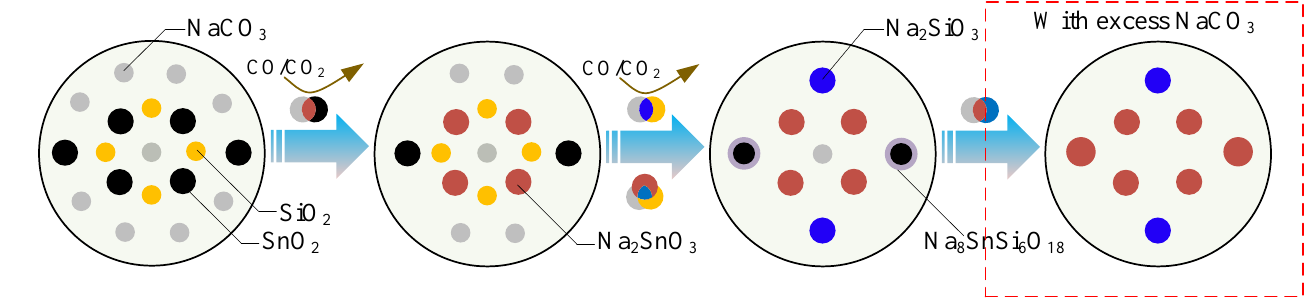
Figure 12. Phase evolution in the SnO 2 – SiO 2 – Na 2 CO 3 system during soda roasting process. First, SnO 2 reacted with Na 2 CO 3 to form Na 2 SnO 3 as shown in Equation (2). Mean- while, part of SiO 2 also reacted with Na 2 CO 3 to form a small amount of Na 2 SiO 3 , see Equation (4). Nonetheless, the reaction rate was much lower than that of Equation (2). Then, Na 2 SnO 3 reacted immediately with Na 2 CO 3 and SiO 2 to form Na 8 SnSi 6 O 18 as shown in Equation (5), and Na 2 SnO 3 was the key intermediate during the formation of Na 8 SnSi 6 O 18 , while the reaction between Na 2 SiO 3 and SnO 2 was impossible. The melting point of Na 8 SnSi 6 O 18 was measured at 825 ◦ C, which was much lower than that of other materials in the SnO 2 –SiO 2 –Na 2 CO 3 system. Thus, Na 8 SnSi 6 O 18 was always formed ac- companied by SnO 2 and invariably closely wrapped around SnO 2 particles, which blocked the contact between SnO 2 and Na 2 CO 3 . Therefore, the formation of Na 2 SnO 3 was signifi- cantly inhibited once Na 8 SnSi 6 O 18 was present. In addition, Na 8 SnSi 6 O 18 is an unstable compound that can react with excess Na 2 CO 3 (Equation (7)) as the roasting temperature and time